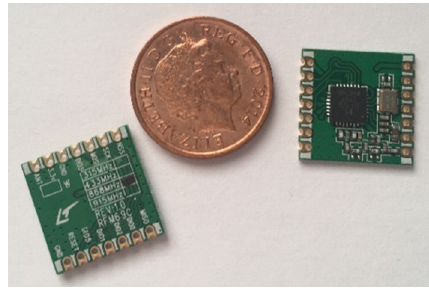
Figure 9. Photo showing two transceivers with a 1p coin .